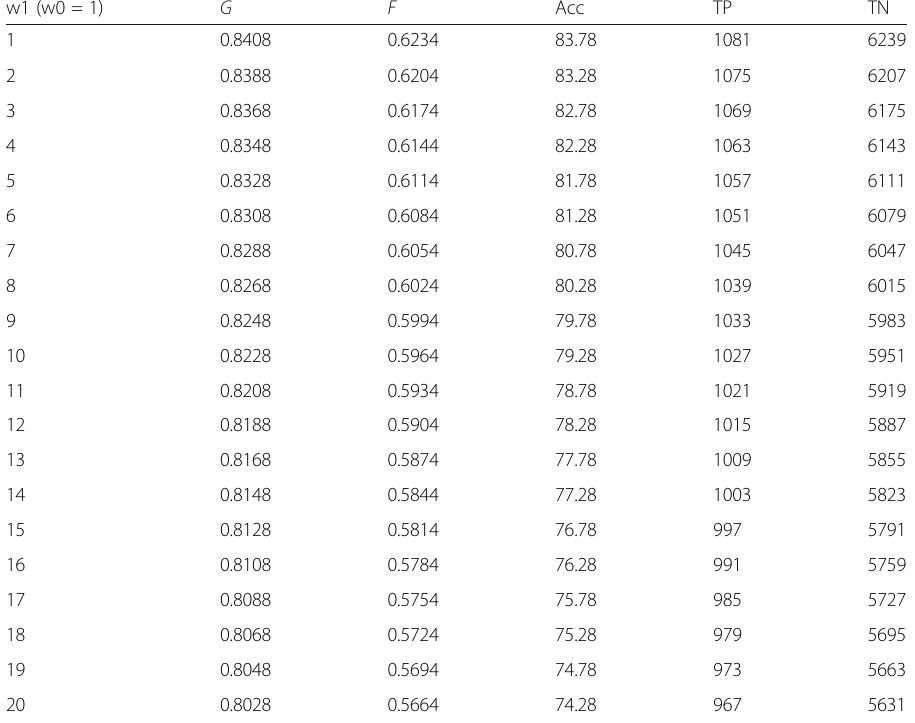
Table 7 DWSVM model weighting coefficient selection